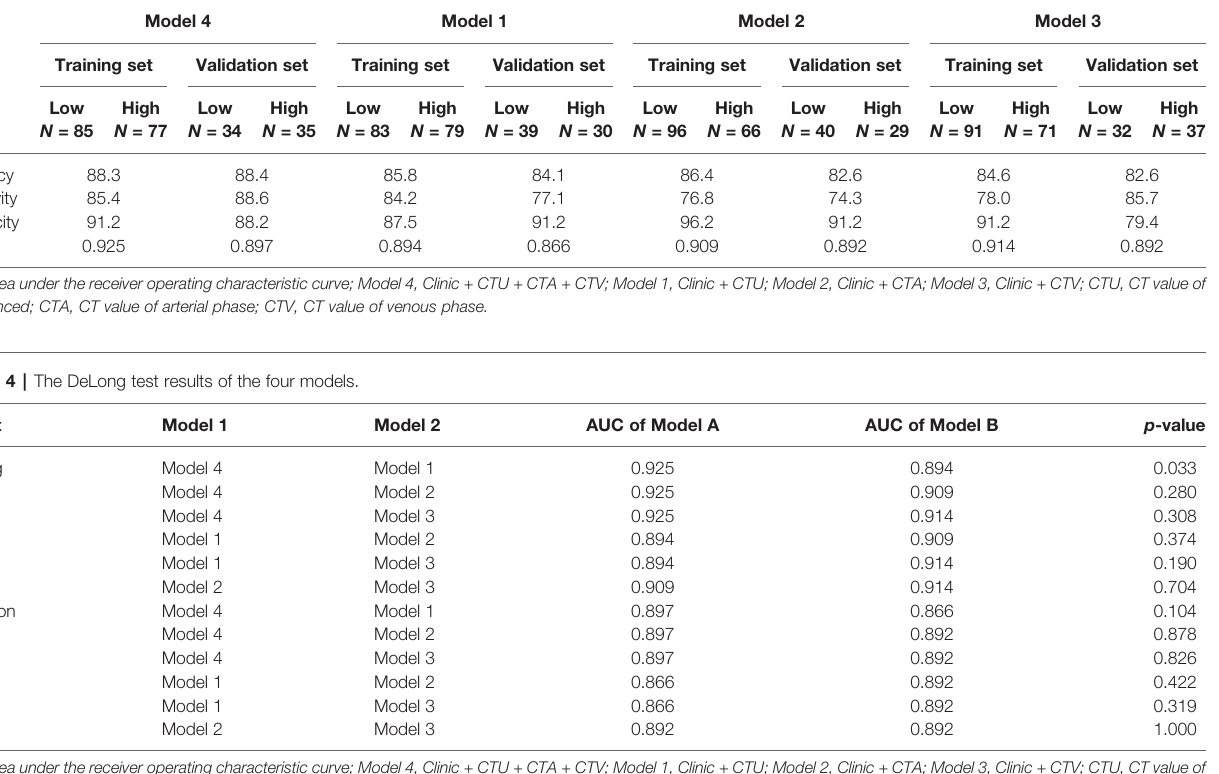
TABLE 3 | Diagnostic ef fi cacy of four models in the discrimination between low-risk and high-risk GISTs in both training and validation sets.